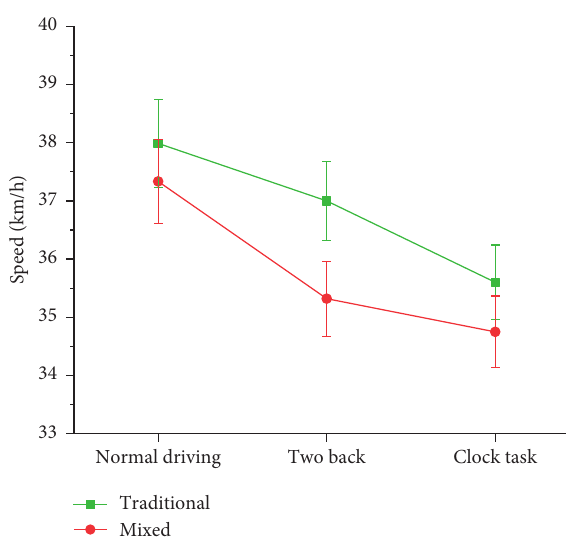
Figure 12: Interaction effect of the driving tasks and traffic en- vironment on the speed.